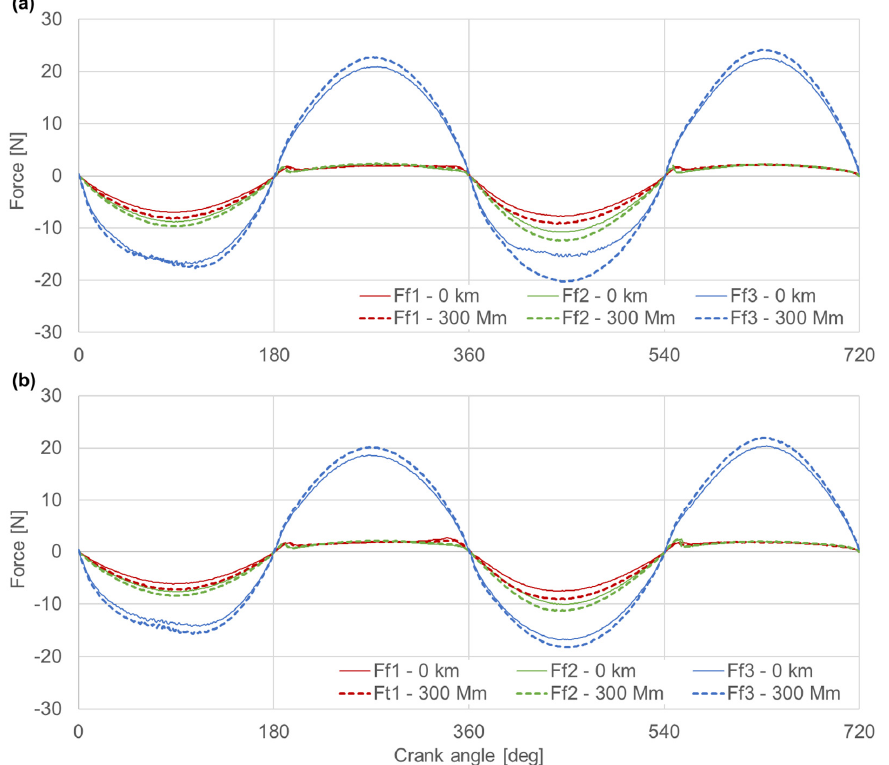
Figure 11. Friction forces between the rings and cylinder liner for different wear and loads: ( a ) load 20 Nm; ( b ) engine load 168 engine load 20 Nm; ( b ) engine load 168 Nm.